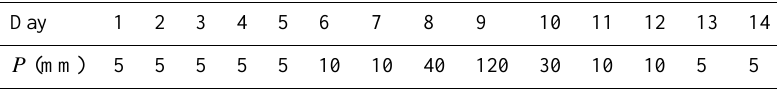
Table A1. Synthetic sequence of extreme precipitation.